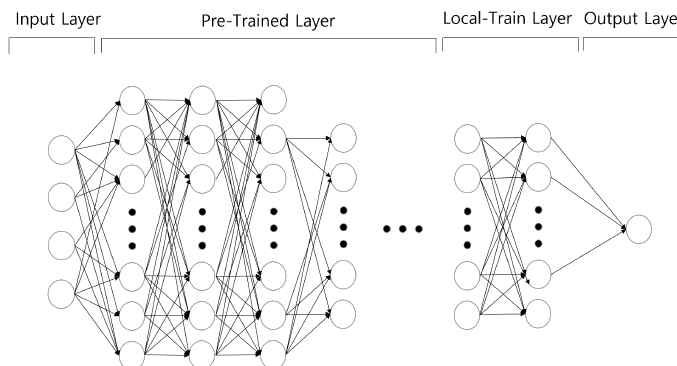
Figure 9. Transfer learning model